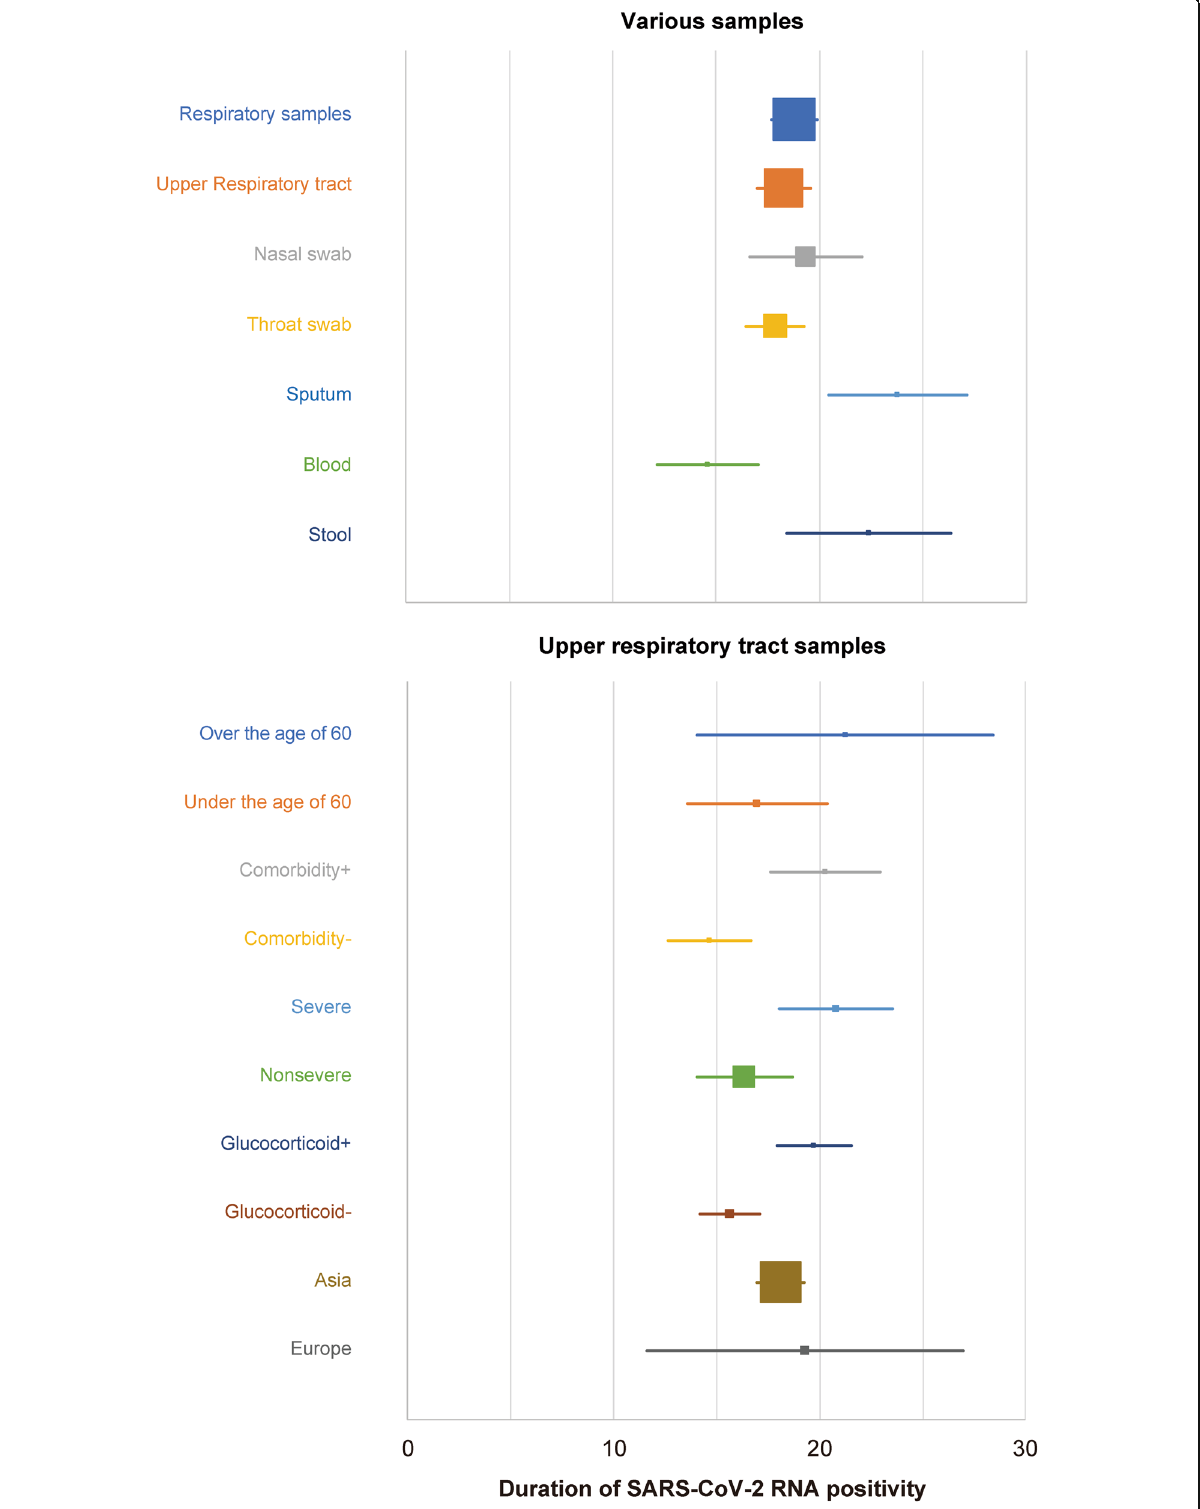
Fig. 10 The summary of the duration of SARS-CoV-2 RNA positivity in the various samples and the clinical